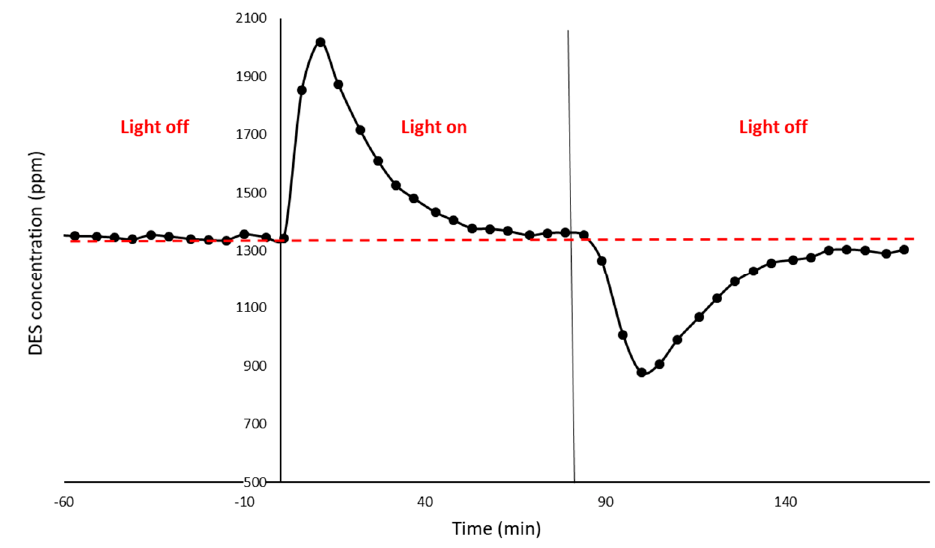
Figure 3. DES photolysis test with β -SiC foam without catalyst under UV-A illumination.